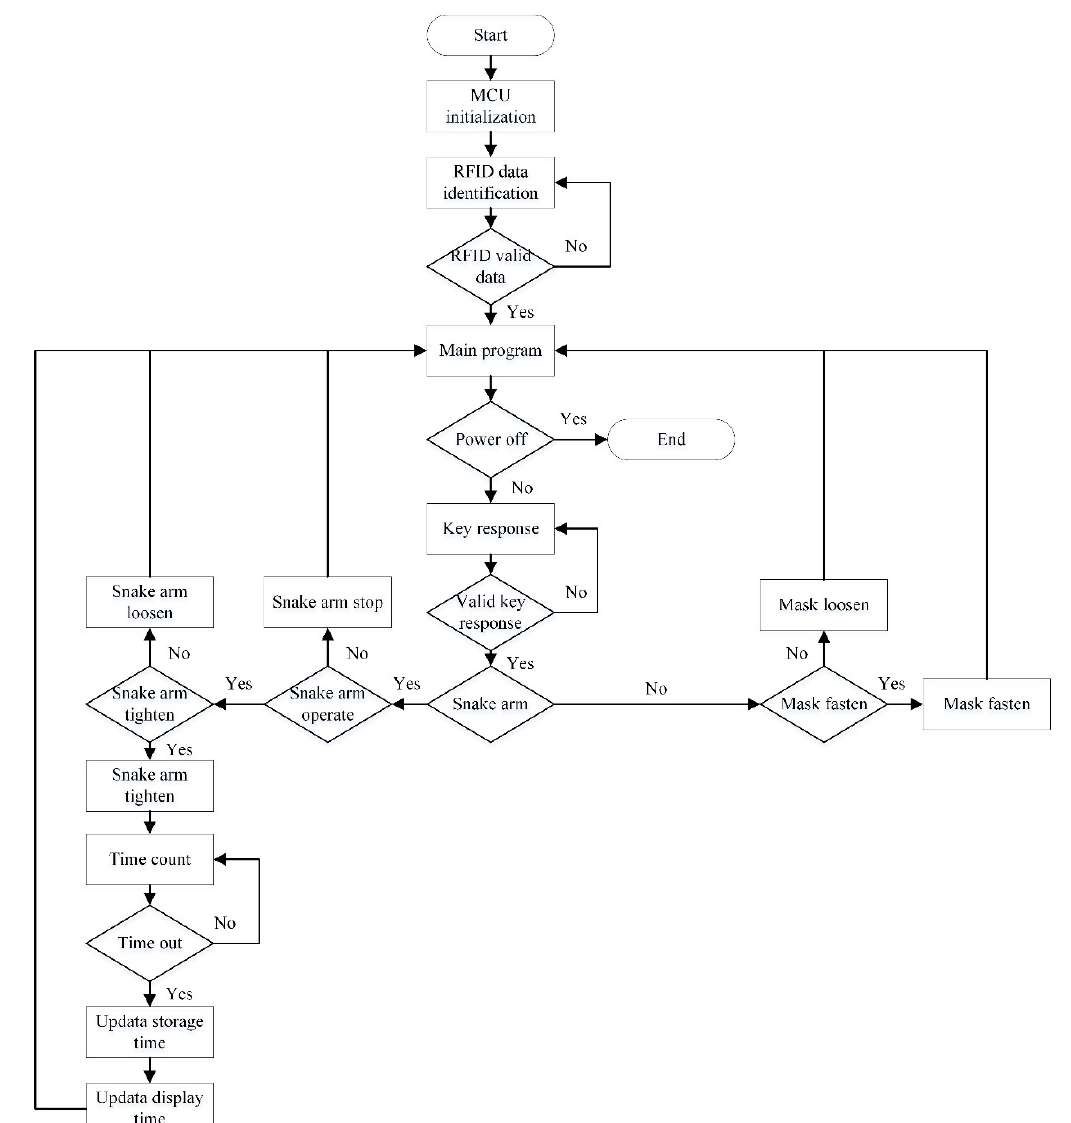
Figure 9. The presented software flow of the control system.